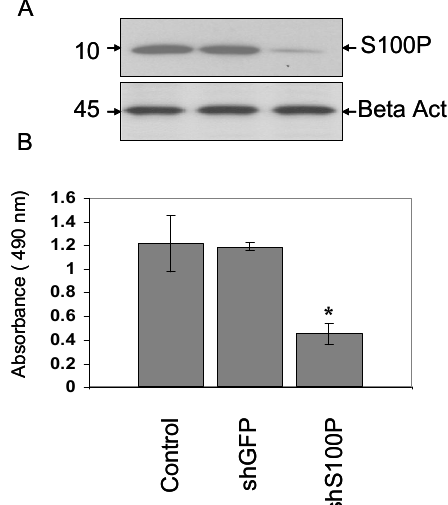
Figure 1. S100P knockdown decreases glioblastoma cells proliferation . ( A ) Western blot verification of S100P protein knockdown in LN-229 glioblastoma cells. ( B ) Cell